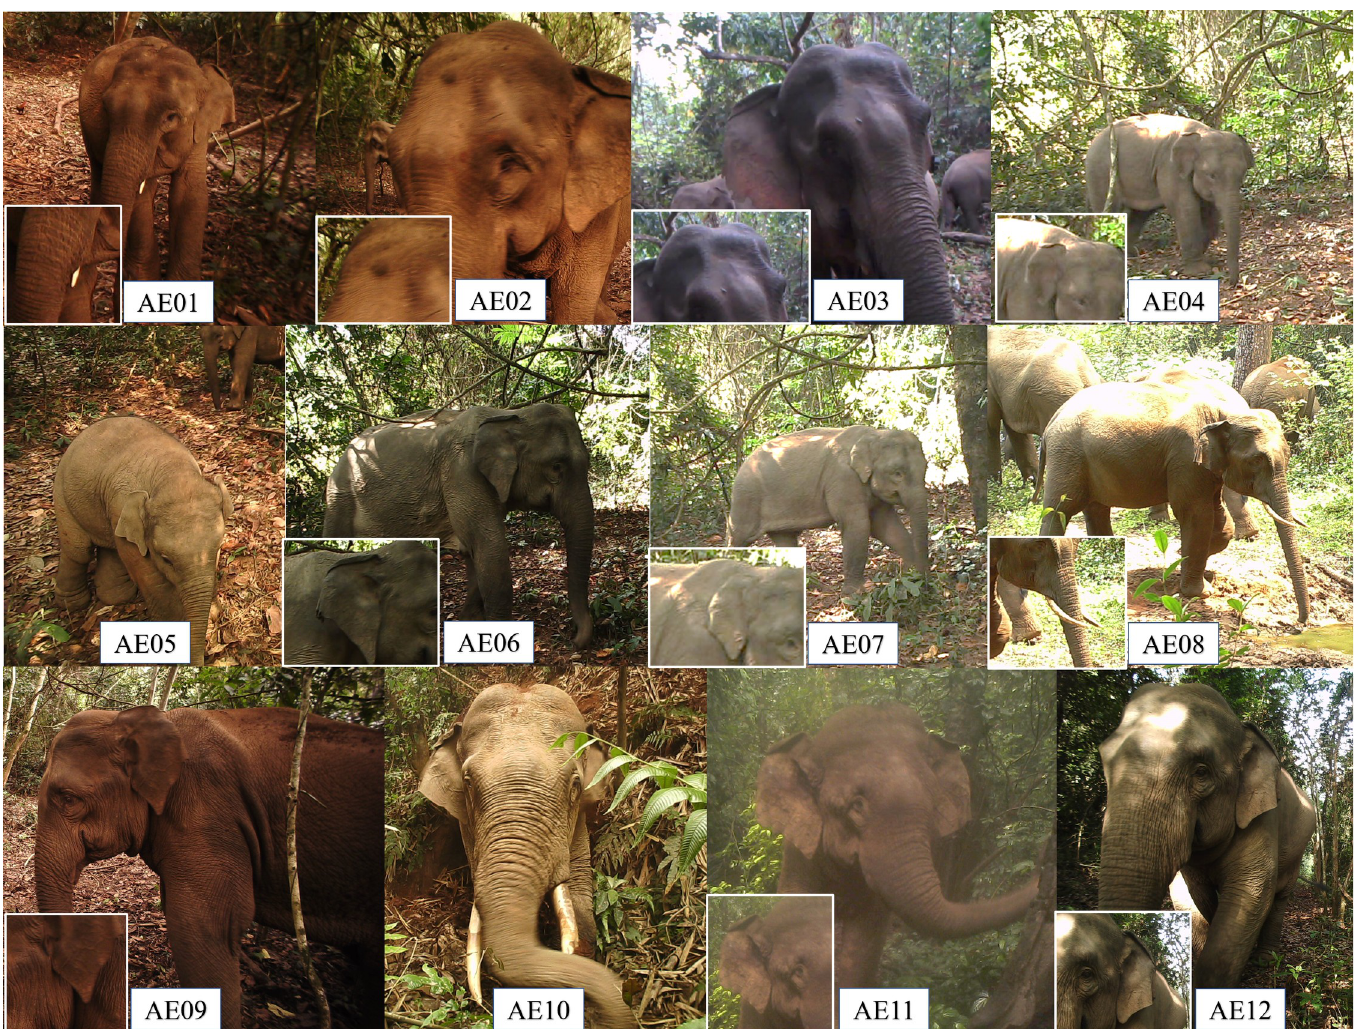
Fig 2. Asian elephants individually identified in NNNR, China. Each individual’s most distinguished characteristic was emphasized, except for the easily identified AE05 and AE10, the only calf and adult male with tusks respectively.